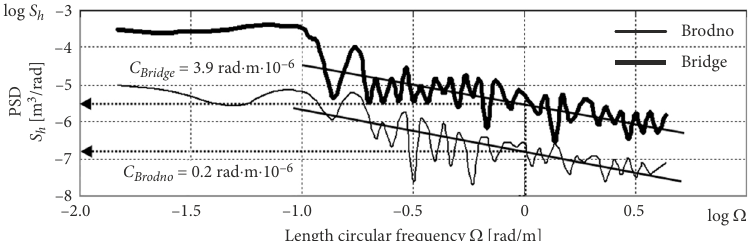
Figure 9. PSD of stochastic unevenness of road sections Brodno and Bridge